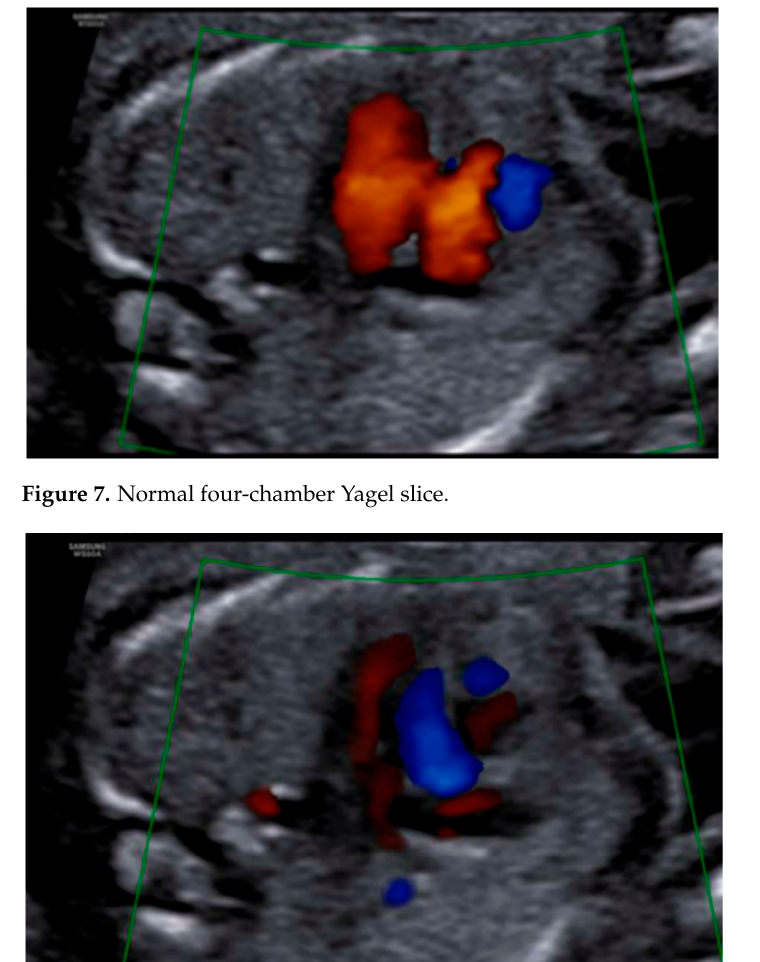
Figure 6. Initial ocular proptosis bilaterally.